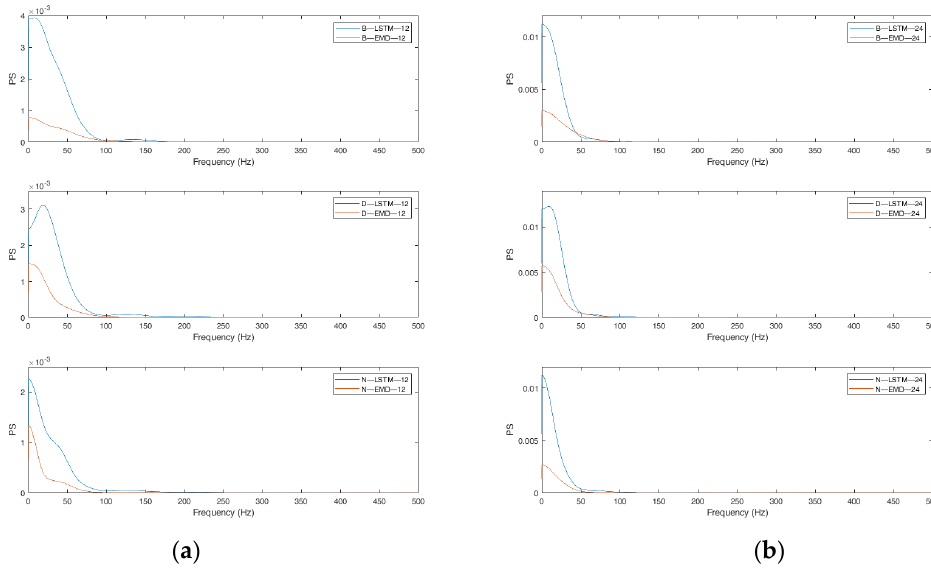
Figure 14. Power spectra of 12 and 24 h significant wave heights. The blue line represents the power value and frequency change curve of the relative error of the LSTM method. The orange line represents the power and frequency variation curve of the relative error of the EMD method. ( a ) represent the 12 h change curves of positions B, D, and N from top to bottom; ( b ) represent the 24 h change curves of positions B, D, and N from top to bottom.